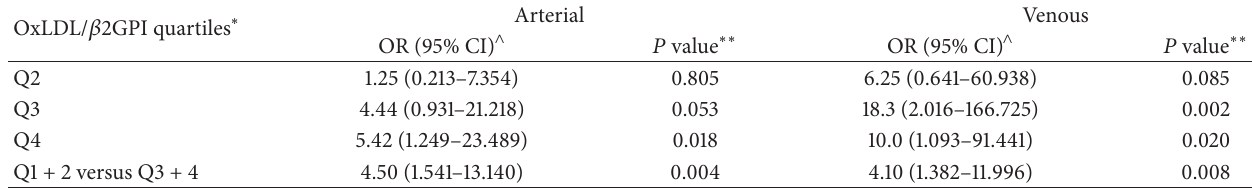
Table 2: Odds ratio (OR) for arterial or venous disease by oxLDL/ 𝛽 2GPI